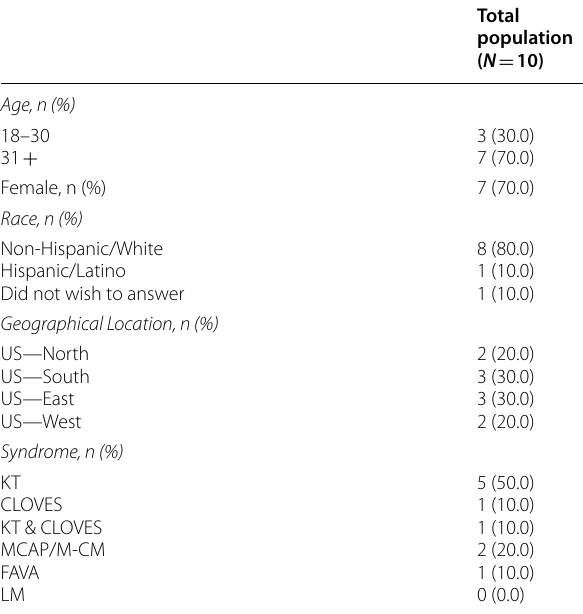
Table 3 Adult (> 18 years) Participant Demographics and